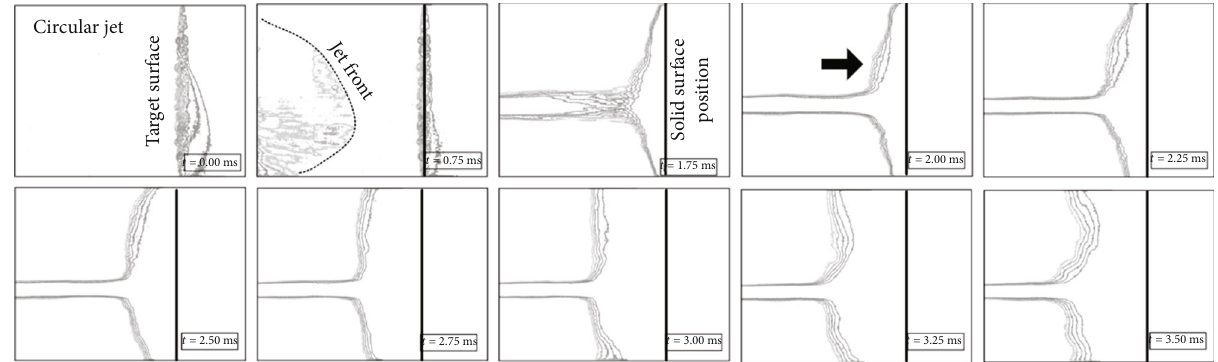
Figure 6: The evolutions of a circular jet impacting a solid surface.